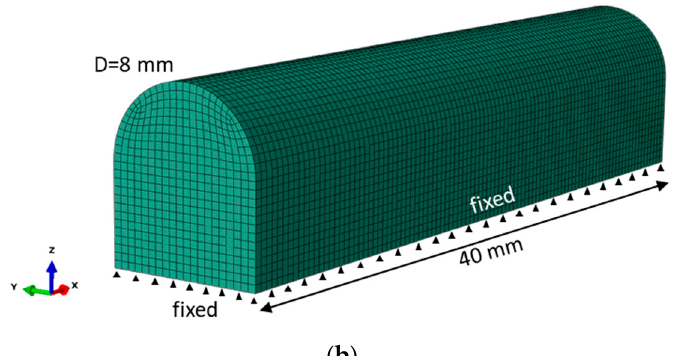
Figure 9. ( a ) Dimensions, boundary conditions and mesh of vertically oriented specimen, ( b ) dimen- sions, boundary conditions and mesh of horizontally oriented specimen.